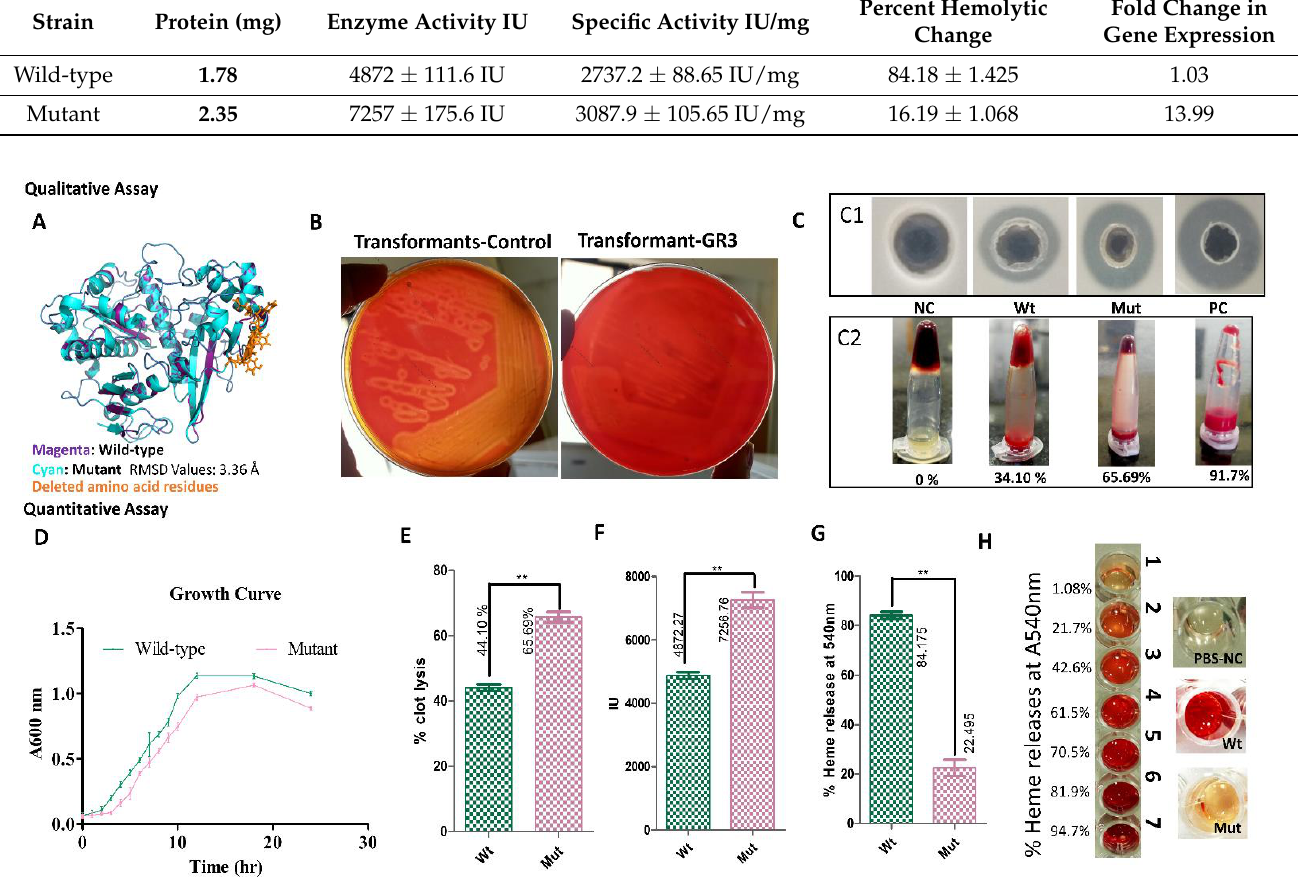
Figure 3. Quantitative and qualitative protein assays of streptokinase and streptolysin. ( A , B ) Wild- type and mutant strains were streaked on blood agar plates with equal 0.05 OD 600nm , to show altered hemolytic activity. ( C ) Streptokinase clot lysis activity: ( C1 ) Zone of fibrin lysis by streptokinase in the thrombin-fibrin agar plate; ( C2 ) Clot lysis assay for streptokinase. NC is abbreviated as a negative control, Wt (wild-type), and Mut (mutant), and PC is a positive control. ( D ) Growth curve for wild-type and mutant strains. ( E ) Percent clot lysis compared in wild-type and mutant strains (**: represent significant with p < 0.05). ( F ) Comparison of IU units within wild-type and mutant strains. ( G ) Streptolysin activity represented using a percentage of heme released by lysis of erythrocytes. ( H ) Change in percentage heme release measured at A 540nm for